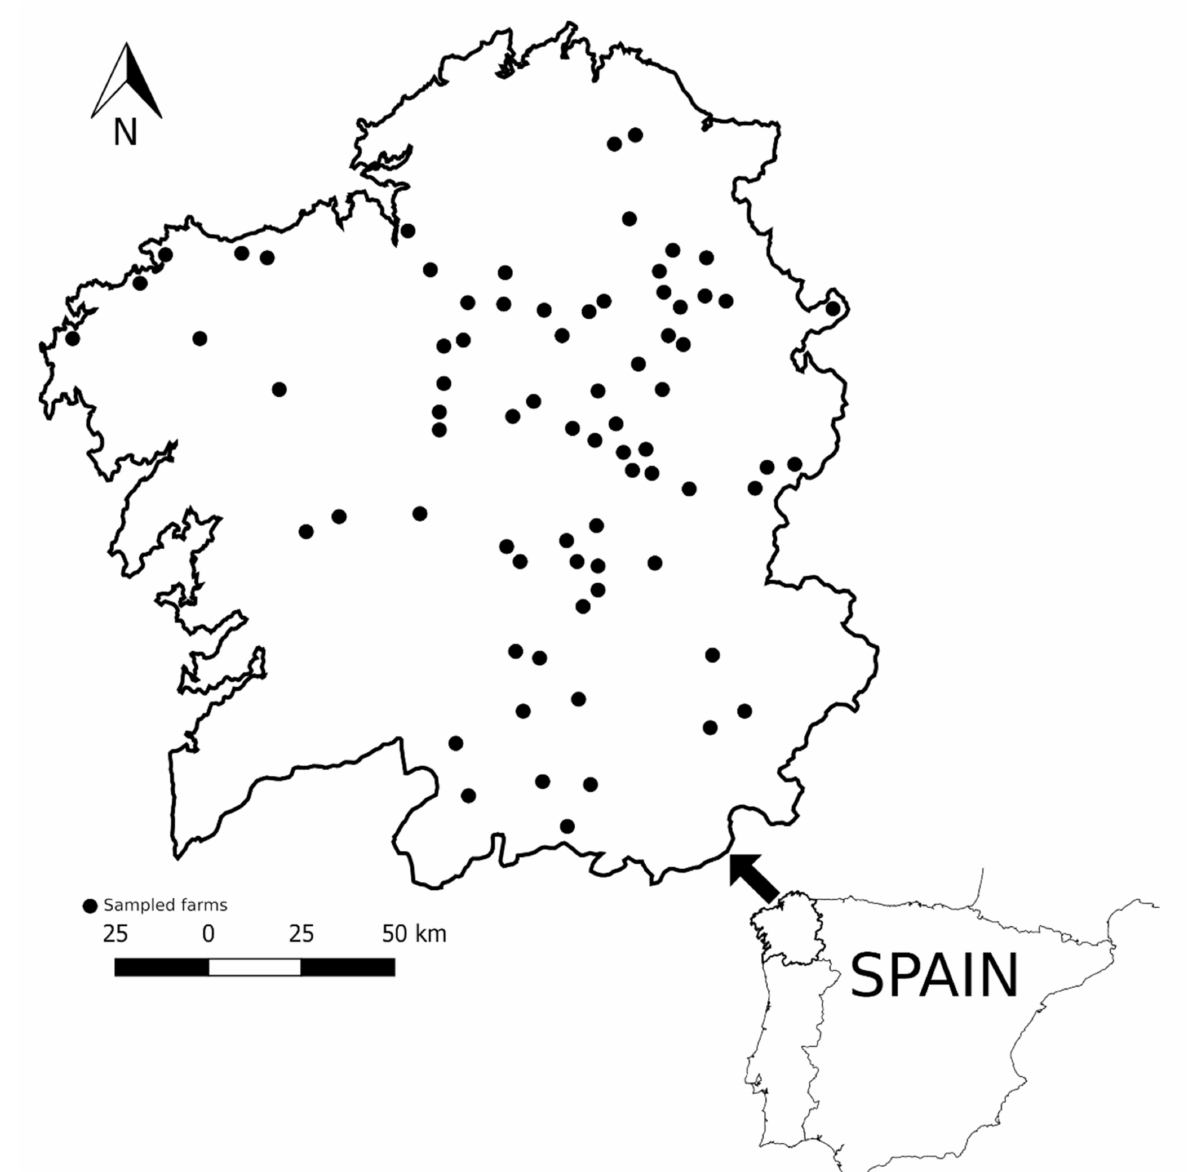
Figure 1. Geographical localization of sampled